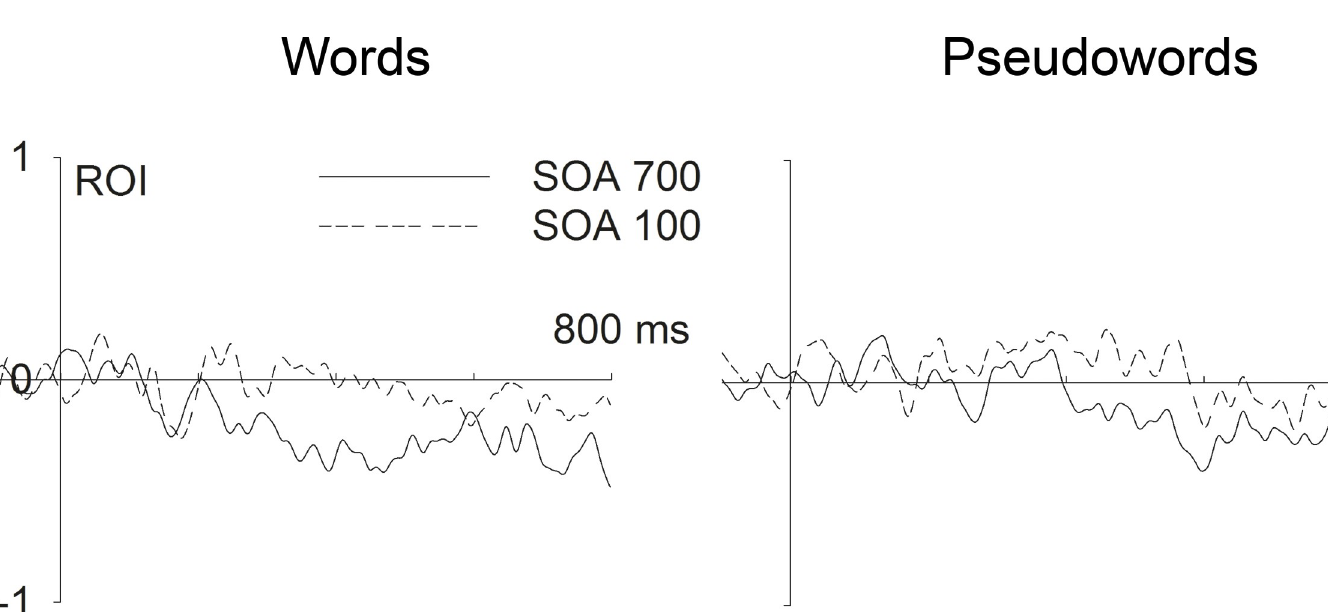
Fig 5. Difference waves corresponding to orthographic neighborhood effects (many minus few orthographic neighbors). For words (left) and pseudowords (right) at a centro-parietal region of interest (ROI; consisting of Cz, CPz, CP1, CP2, and Pz), as a function of task overlap (SOA 700 vs. SOA 100).